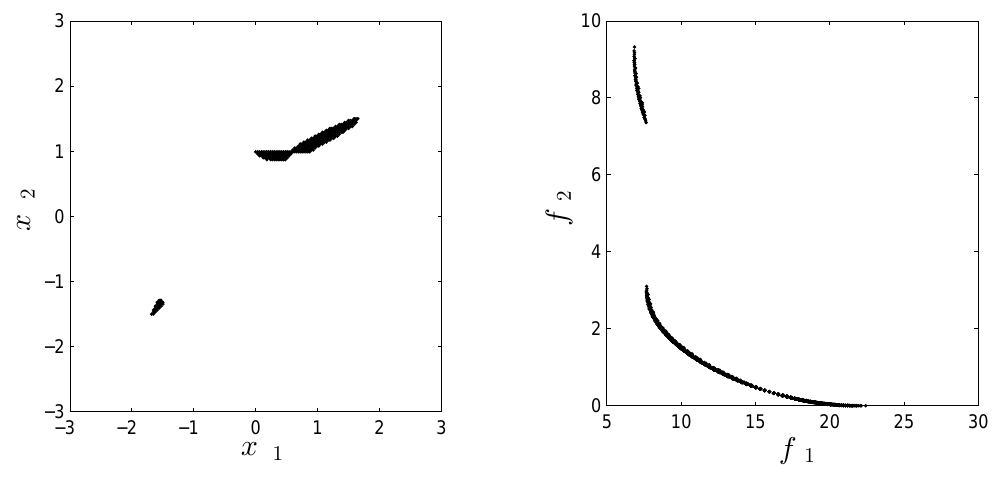
Figure 2. Numerical results of GCM on the academical problems. Decision space ( left ) and objective space ( right ) obtained on the problems Deb99 and two-on-one from above to below.